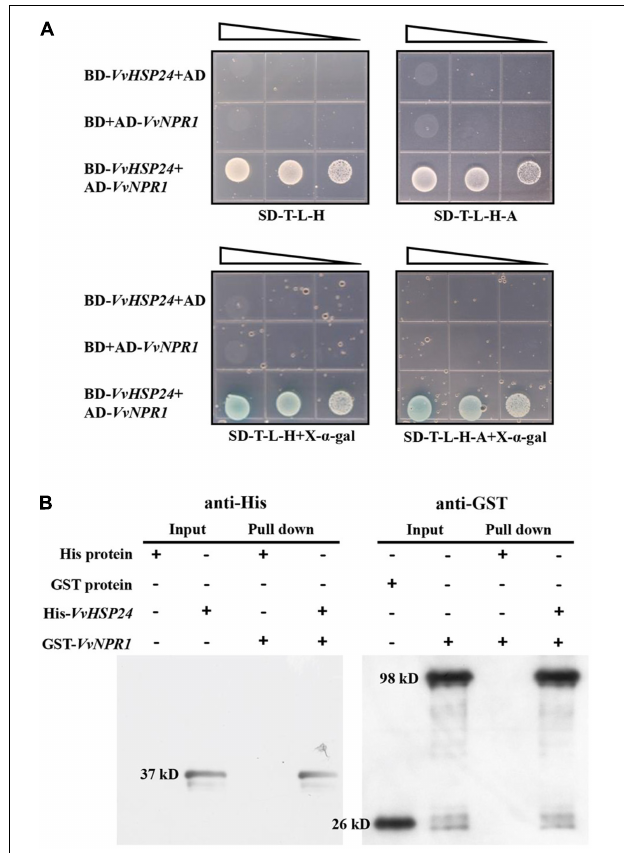
FIGURE 5 | VvHSP24 interacts with VvNPR1 in vivo and in vitro . (A) Yeast two-hybrid analysis of the physical interaction between VvHSP24 and VvNPR1 . SD-T-L-H, SD/-Trp-Leu-His agar medium; SD-T-L-H-A, SD/-Trp-Leu-His-Ade agar medium. The right-angled triangles on the top of the gridded Petri dishes represent the absorbance of yeasts at 600 nm in a 10-fold dilution series, from 1 to 10 − 2 abs. (B) The GST-fused VvNPR1 protein (1 mL) was incubated with 1 mL of preimmobilized His- VvHSP24 protein in a total volume of 25 mL at 4 ◦ C for more than 8 h. The pulled down proteins (6 µ L) were analyzed by western blotting with anti-His or anti-GST